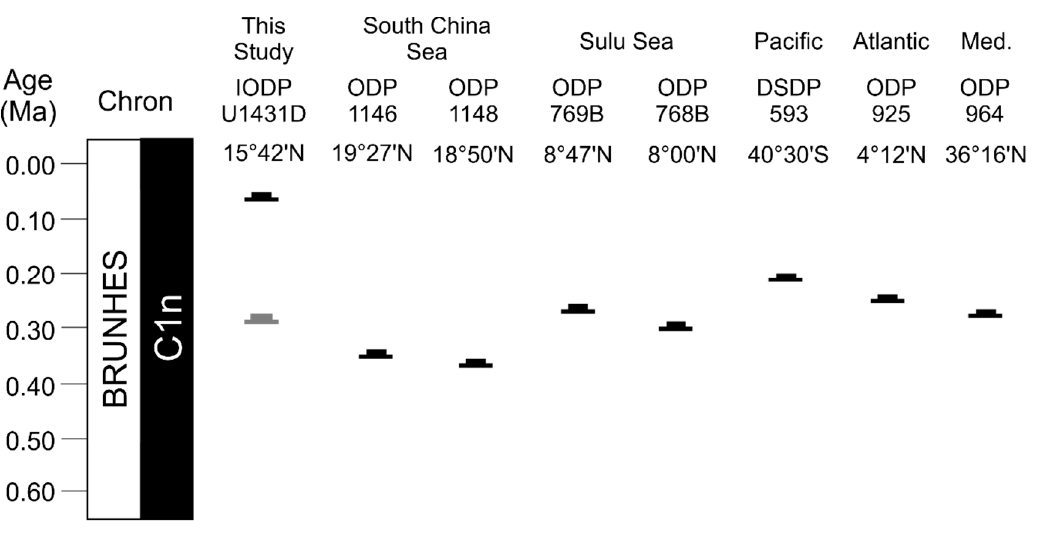
Figure 11. Comparison of stratigraphic ranges of FO of Emiliania huxleyi from IODP / ODP / DSDP Sites. Magnetostratigraphic records from IODP Site U1431D, ODP Sites 1148, 769B, 768B, and DSDP Site 593 are calibrated to the astronomically tuned Geomagnetic Polarity Time Scale (GPTS) of [61] as compiled by [9]. Oxygen isotope data is used to determine the ages in ODP Sites 1146, 925 and 964. These datums are calibrated to the benthic foraminiferal δ 18 O time scale of [2]. Horizontal bars represent the recalculated datum ages for each site. Black datum in IODP Site U1431D represents age acquired from magnetostratigraphy. Gray datum in IODP Site U1431D represents placement of the datum from this study using the datum age reported in [9]. Med.—Mediterranean.